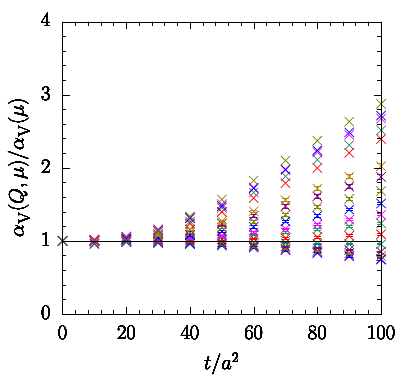
Figure 7. The ratio α V p Q ,µ q{ α V p µ q as a function of t { a 2 on the 24 4 lattice for charges ranging from Q “ 0 (bottom) to | Q | “ 16. No errorbars are shown for marginal values of Q because of limited